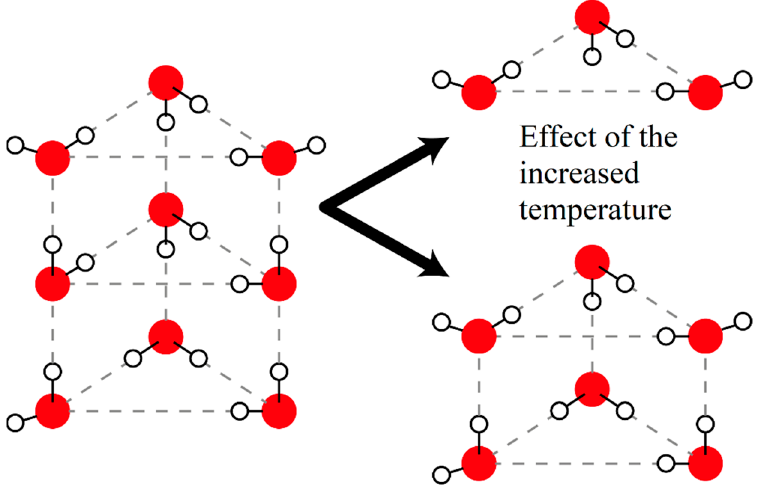
Figure 4. A schematic model of (H 2 O) 9 clusters breaking off to (H 2 O) 3 rings and (H 2 O) 6 clusters [30] due to the higher temperature.